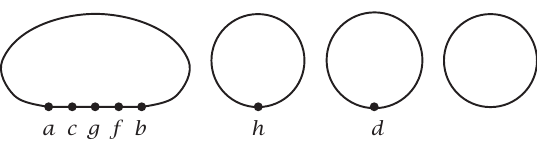
Figure 7.3 . Replacing a chord.